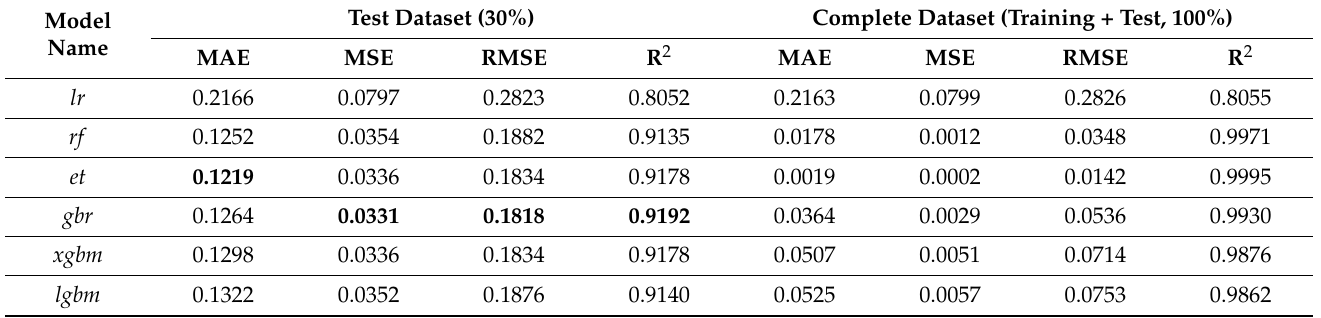
Figure 13. Residual plots of the trained algorithms. Note: Predicted price values on the abscissa axis in a natural logarithm, ordinate axis with standardized errors. Table 6. Error and goodness-of-fit measures for the algorithms on different datasets (various metrics).